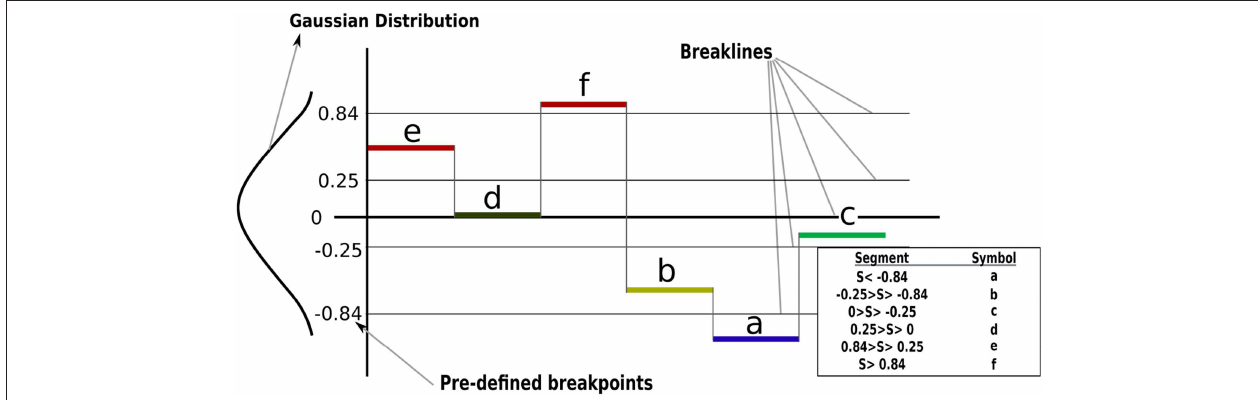
FIGURE 2 | Segments mapping into a symbolic representation of time-series data. For example, the time-series is segmented into six segments and each segment mapped into a symbol based on its location with respect to the Gaussian distribution (breaklines).